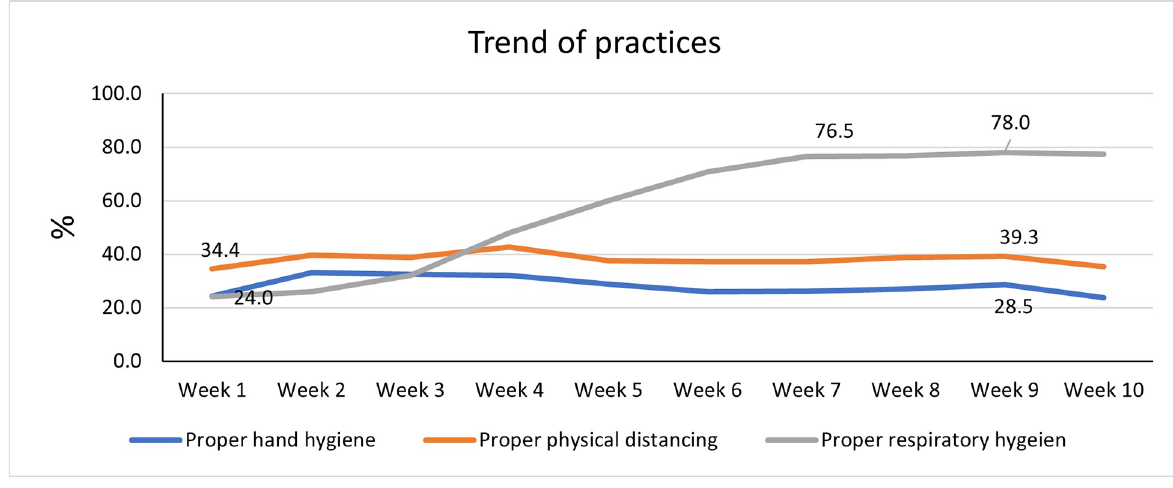
Fig 2. The overall trend of the proper community practices for the three NPIs.